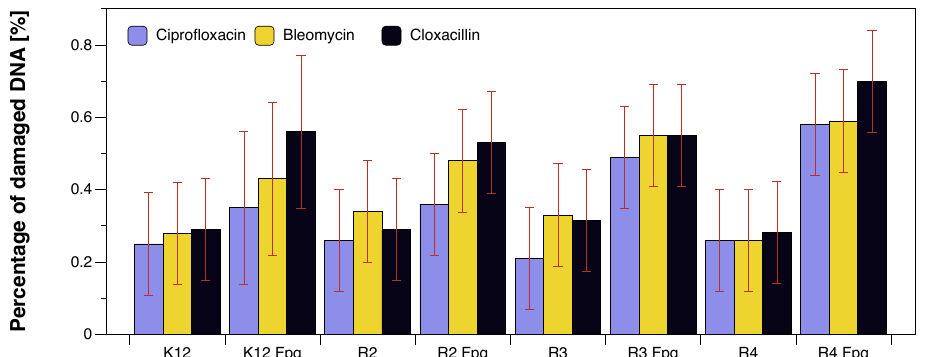
Figure 7. The percentage of bacterial DNA recognised by Fpg enzyme in model bacterial strains after ciprofloxacin, bleomycin, and cloxacillin treatment. The compounds were statistically significant at p < 0.05. Each experiment was performed independently in three replications (n =